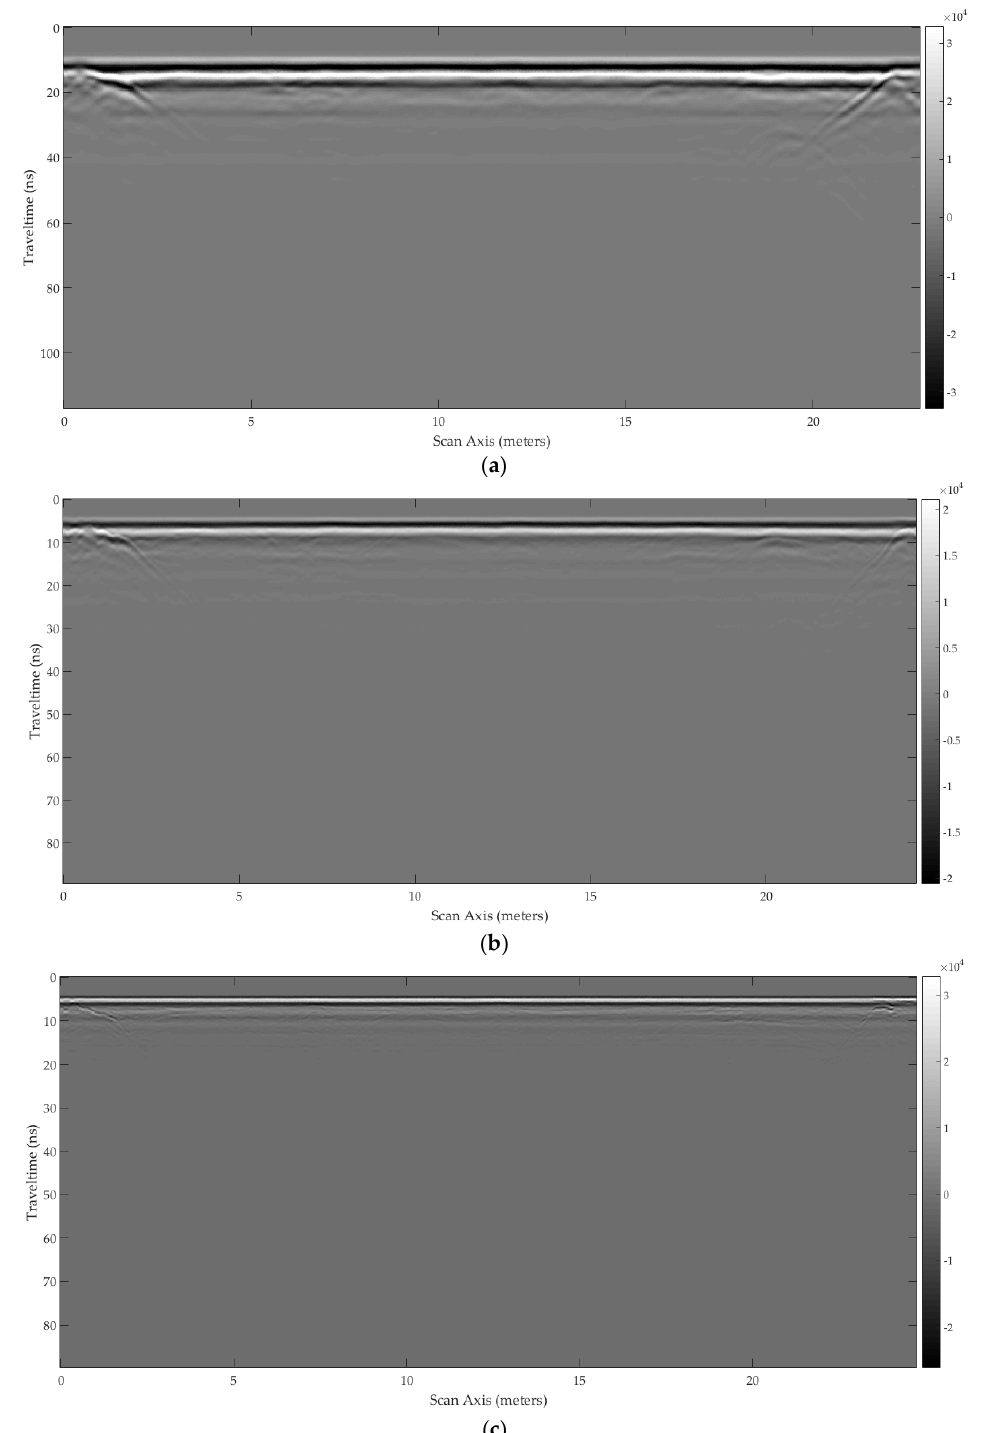
Figure 38. Profiles recorded in the Gneiss 0/20 gravel region by using GPR 2, on acquisition line 1, with antennas operating at: ( a ) 250 MHz; ( b ) 500 MHz; ( c ) 800 MHz.